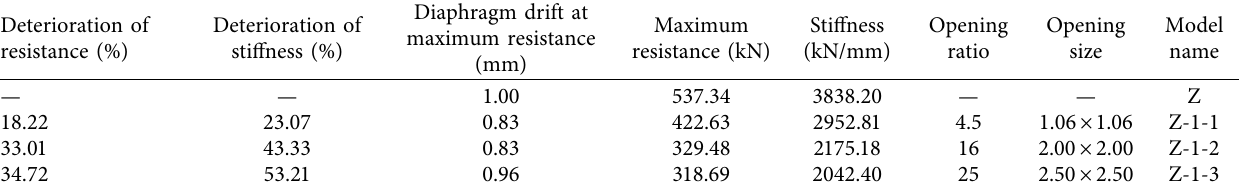
Table 8: Obtained parameters and results from models with opening with different areas under loading in Z direction. Deterioration of resistance (%)